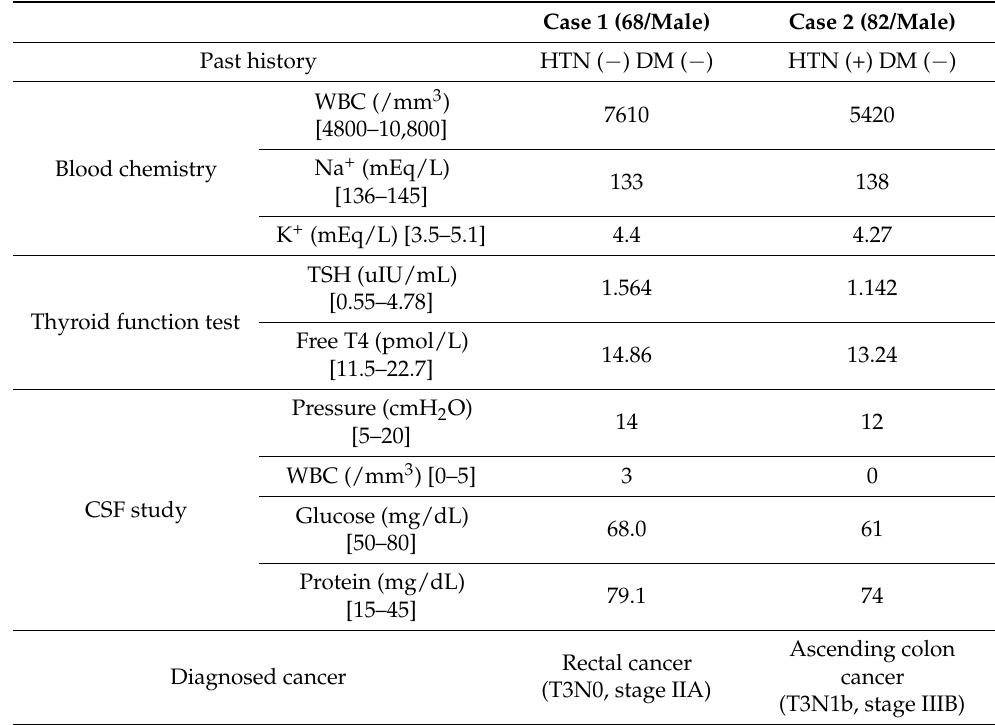
Table 1. Patients’ information. CSF—cerebrospinal fluid; DM—diabetes mellitus; HTN—hypertension; K—potassium; Na—sodium; TSH—thyroid stimulating hormone; WBC—white blood